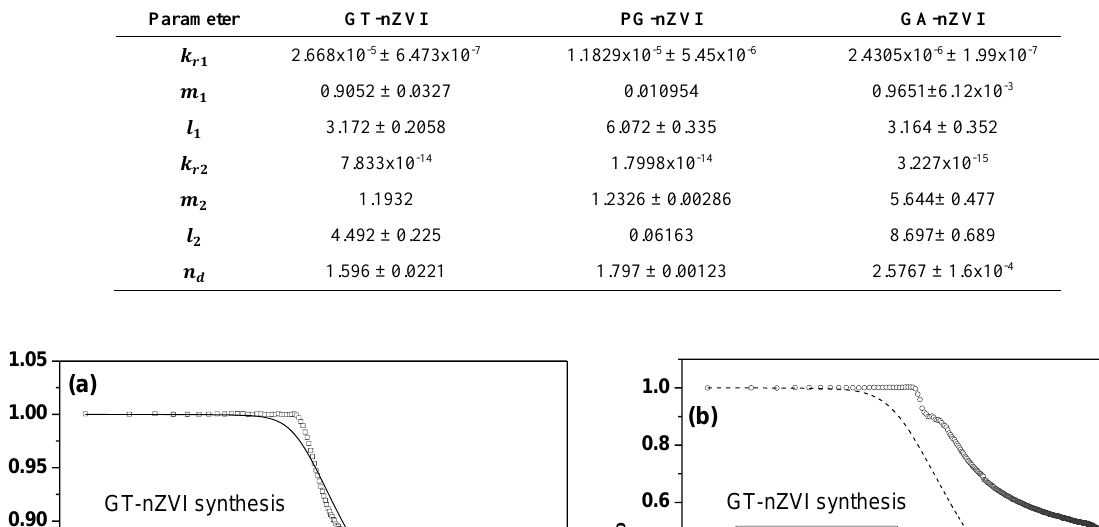
Table 4. Estimated parameter values and confidence intervals.